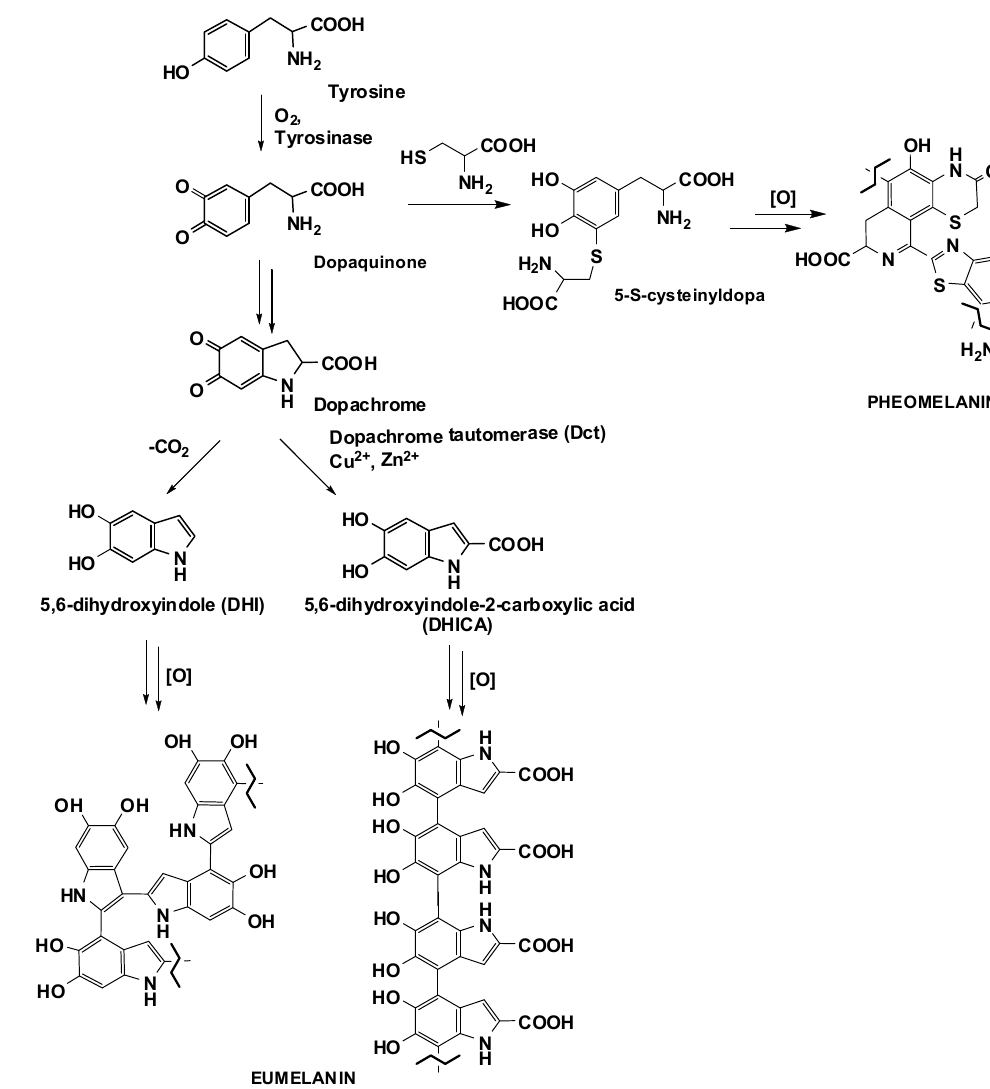
Figure 1. Biosynthetic pathways leading to eumelanins and pheomelanins.